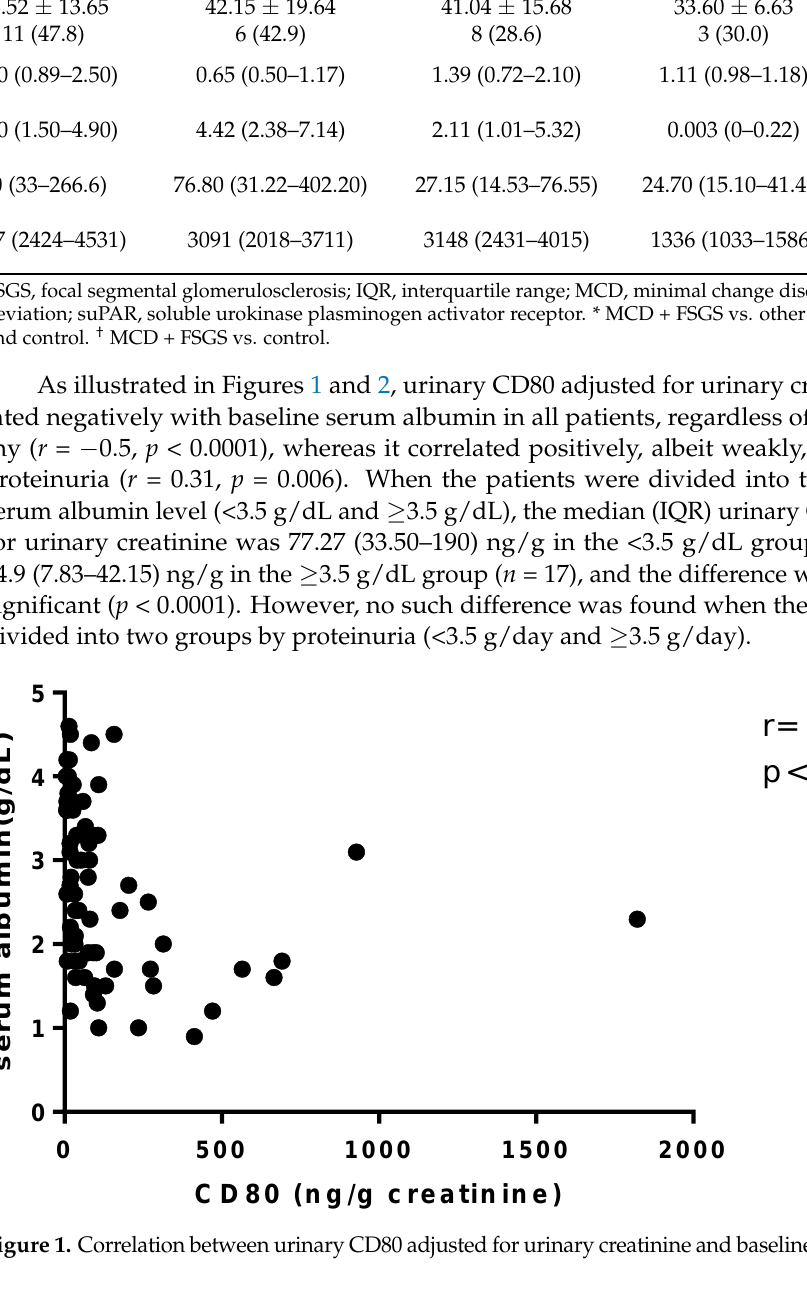
r = 0 . 31 p 0 . 006 Figure 2. Correlation between urinary CD80 adjusted for urinary creatinine and baseline pro- teinuria. When the patients were divided into two groups by serum creatinine (<1.2 mg/dL and ≥1.2 mg/dL), the median (IQR) serum suPAR was found to be 3066 (2184 – 3409) pg/mL in the <1.2 mg/dL group and 4065 (2935 –5405) pg/mL in the ≥1.2 mg/dL group, and the difference was statistically significant ( p = 0.0006). Among the patients with FSGS ( n = 18), urinary CD80 and serum suPAR did not differ significantly between those with collapsing FSGS ( n = 9) and those with other forms of FSGS ( n = 9). The median (IQR) urinary CD80 was 91 (35.95 – 254.10) ng/g in those with collapsing FSGS and 46.30 (18 – 254) ng/g in those with other forms ( p = 0.42). The median (IQR) serum suPAR was 3278 (2138 – 4709) pg/mL in the patients with collapsing FSGS and 3972 (3470 – 5235) pg/mL in those with other forms ( p = 0.29).